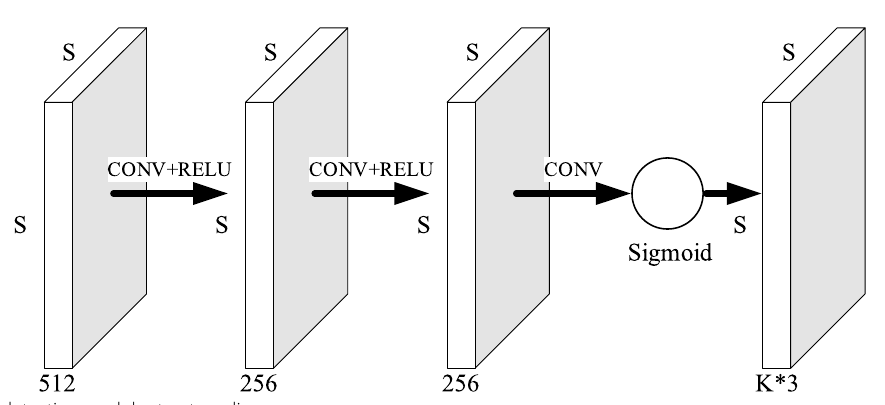
Fig. 10 Key point detection module structure diagram